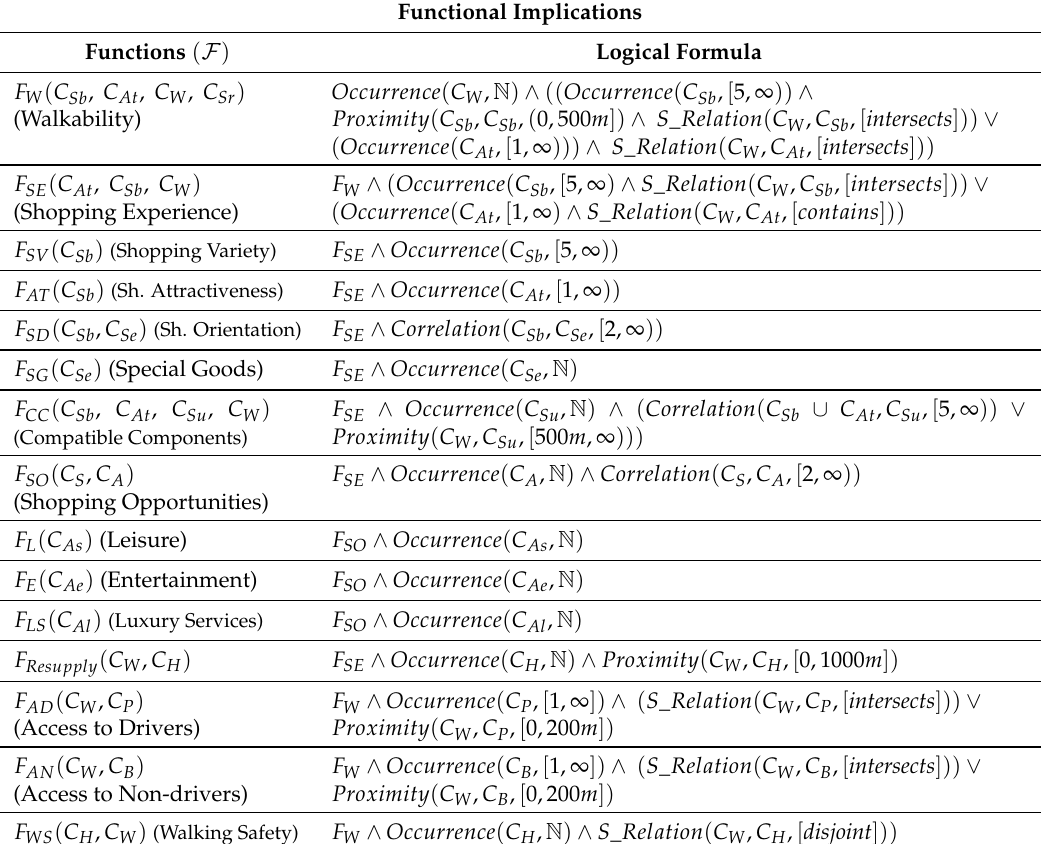
Table A3. Composition pattern of a shopping